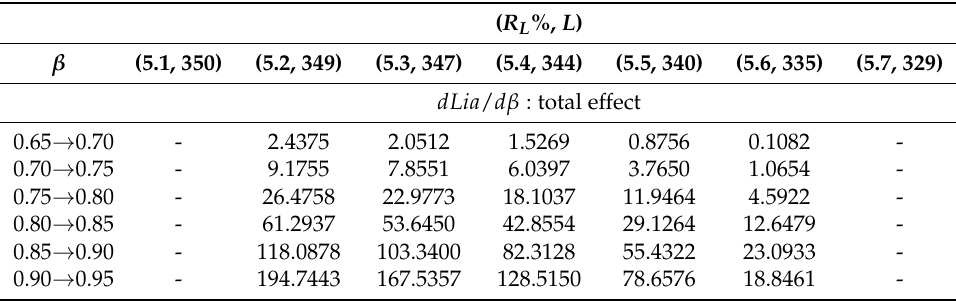
Table 7. Responsiveness of the bank’s liabilities to barrier 1